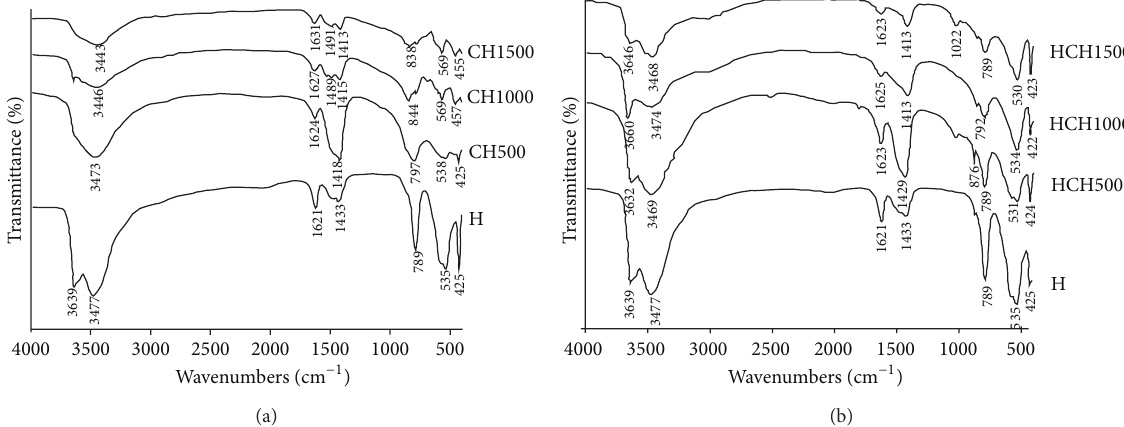
Figure 3: IR spectra of hydrocalumite samples calcined at 500, 1000, and 1500 ∘ C (a) and their rehydrated products (b). The IR spectra of an original hydrocalumite sample were presented in the figures for comparison.